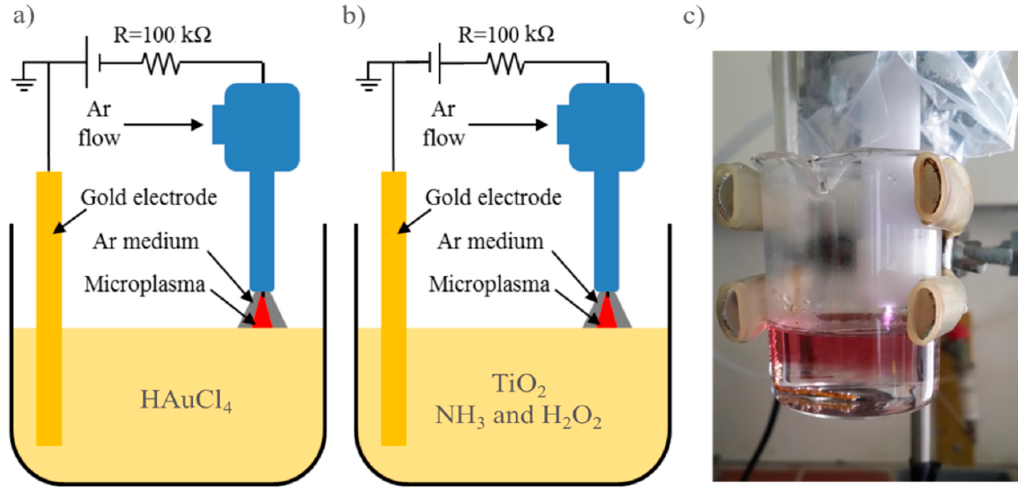
Figure 1. Micro-discharge workstation for ( a ) the electrochemical gold reduction, ( b ) the TiO 2 treatment and ( c ) image of running plasma for gold nanoparticle synthesis from HAuCl 4 0.06 mM precursor solution.